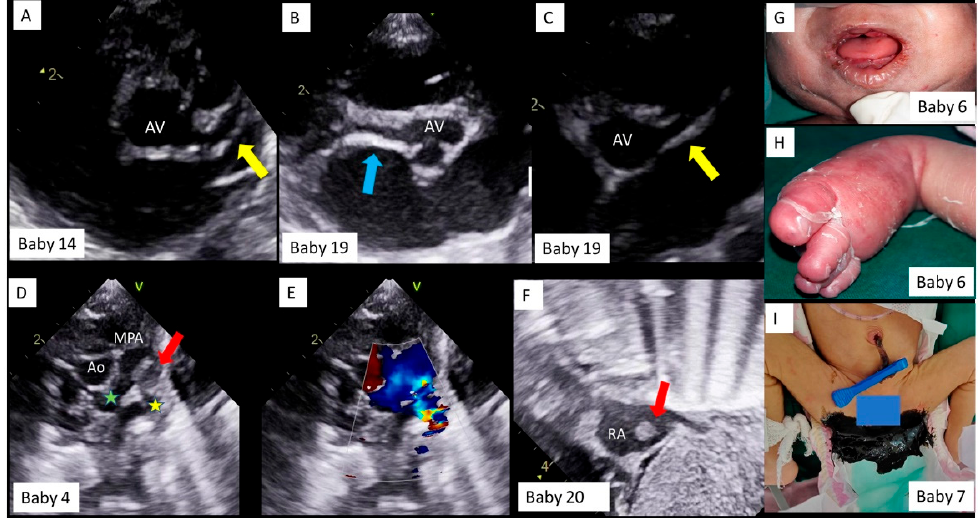
Figure 3. Echocardiography and clinical findings in neonates with MIS-C. Baby number sequence is the same as in Table 3. Transthoracic echocardiography, parasternal short axis view in Baby #14 ( A ) and Baby #19 ( B , C ). The left main and left anterior descending coronary artery (yellow arrow) and the right coronary artery (blue arrow) are significantly dilated. AV = aortic valve. Transthoracic echocardiography and color doppler, parasternal short axis view in Baby #4 ( D ), showing aorta (Ao) and main pulmonary artery (MPA) bifurcation, with a large thrombus (red arrow) obstructing the left pulmonary artery (yellow star) origin and causing flow turbulence on color doppler ( E ), but normal flows across right pulmonary artery (green star). Transthoracic echocardiography subcostal bi-caval view in Baby # 20 ( F ), showing a thrombus (red arrow) in right atrium (RA). Baby #6, showing oral and muco-cutaneous lesions ( G ) and, pedal edema and skin peeling ( H ) and Baby #7 with black, tarry stools (melena, I ).